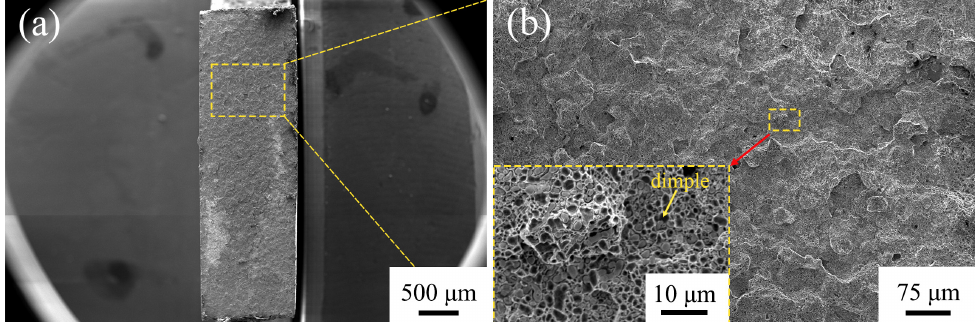
Figure 11. The fracture morphologies of TLP-diffusion-bonded joint using low-B interlayer. ( a ) Macro- scopic fracture morphology; ( b ) Expanded region in ( a